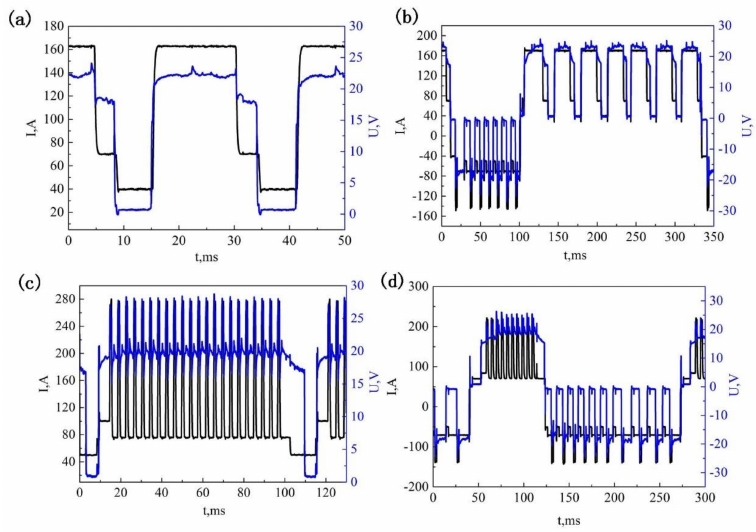
Figure 2. Measurements of arc current and voltage waveforms of ( a ) CMT; ( b ) CMT-ADV; ( c ) CMT-P, and ( d ) CMT-PADV.